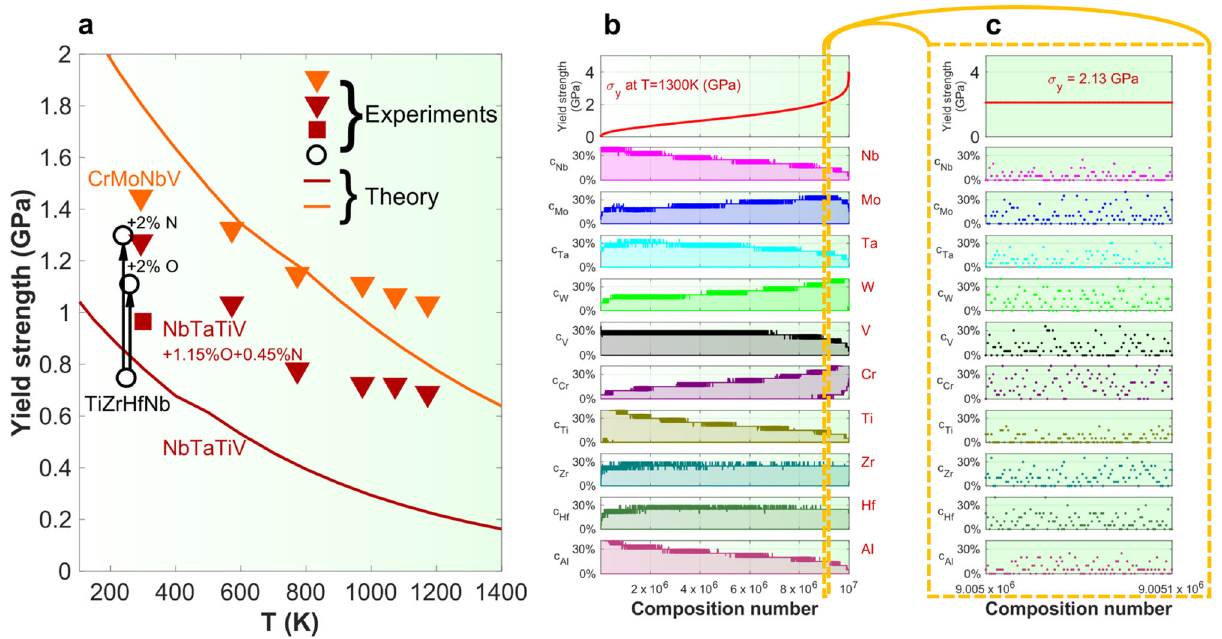
Fig. 4 Theory predictions of yield strengths in BCC HEAs. a Yield strength vs. temperature, experiments and theory for NbTaTiV and CrMoNbV. NbTaTiV: Experiments on the NbTaTiV alloy with 1.15 at.% O and 0.45 at.% N: red triangles at a strain rate of 10 − 3 s − 1 ; theory for an interstitial-free alloy: red line. Red square reported in ref. 9 at 5 × 10 − 4 s − 1 with no O or N impurity content reported. Black circles: experiments on TiHfZrNb at T = 300 K with and without 2 at.% O and N that show strength increases up to ~500 MPa 21 , comparable to the difference here between model predictions for the interstitial-free NbTaTiV and the experiments with 1.6 at.% impurities. CrMoNbV: Experiments: orange triangles; theory: orange line; no impurities are detected in this alloy. The strength of the new CrMoNbV at 1173 K exceeds those of all previously reported alloys. b Theory predictions for T = 1300 K strength vs. composition. As detailed in Supplementary Note 7, computations of the yield strengths have been performed for >10,000,000 alloys. The alloys have been assigned with an increasing number as a function of the increasing strength. Thus, the lowest strength alloy is the number 1, and the highest strength alloy is the number 10,003,049. For better visualization, we have grouped the alloys into bins containing 1000 compositions each (see Supplementary Note 7). The lowest compositions are for alloys 1 to 1000 and enter the 1st bin. The second bin contains alloys 1001 to 2000, etc. Within each bin, the interval between the 10th and the 90th percentiles of the elemental contents (Nb, Mo, Ta, etc.) is computed. In this panel, the shaded areas indicate the concentrations between the 10th and the 90th percentiles, evaluated over the compositional bins. Thus, the y axis is the elemental concentration. The screening includes >10,000,000 compositions in the Nb-Mo-Ta-W-V-Cr-Ti-Zr-Hf-Al compositional space. c A zoom-in of the screening for 100 compositions around the 1,000,000 strongest alloys (between composition numbers of 9,005,000 and 9,005,100). Here, the actual alloy contents per composition number are shown. There are plenty of possible alloys that can have the same yield strength, but different Figure 4b and c (see the Supplementary Note 7 for more details) show ~6,000,000 alloys with estimated strengths over